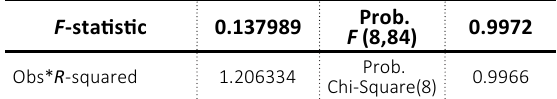
Table 5. Autoregressive conditional